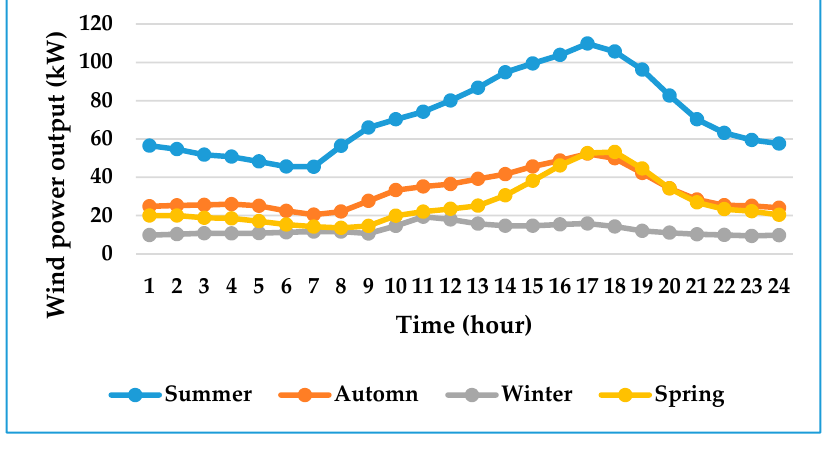
Figure 6. Power output of wind turbine